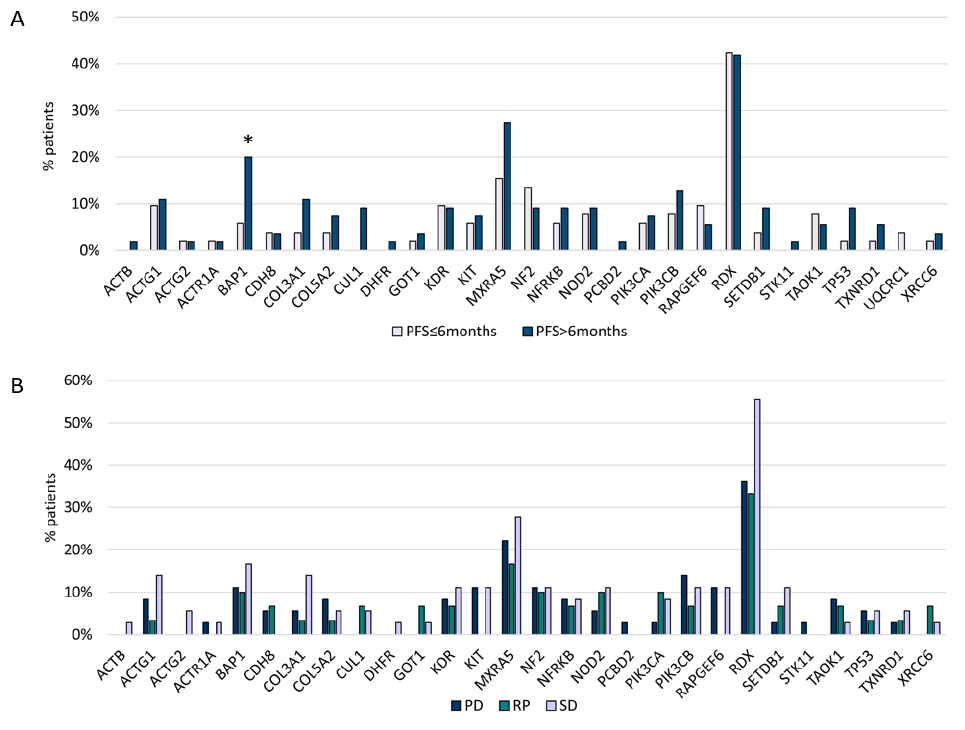
Figure 4. ( A ) Gene mutations and first-line chemotherapy PFS. ( B ) Gene mutations and first-line chemotherapy ORR. * Statistically significant ( BAP1 p = 0.04).